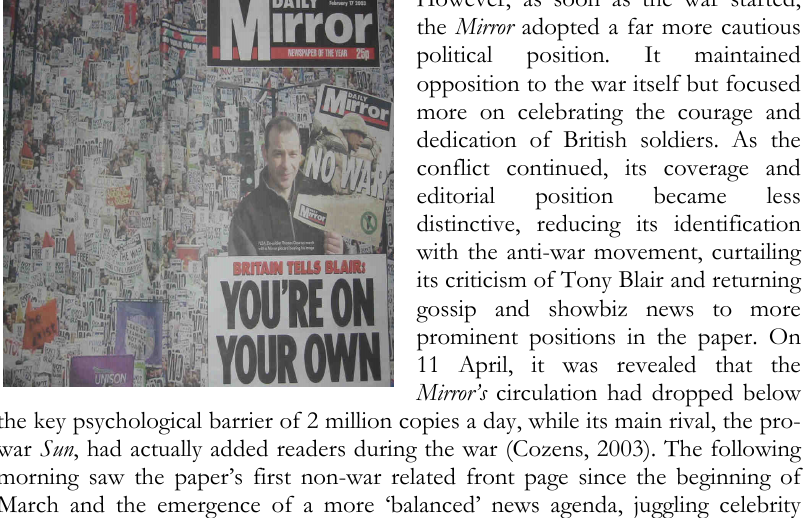
Figure 5. ‘The Mirror’s special issue on the huge anti-war